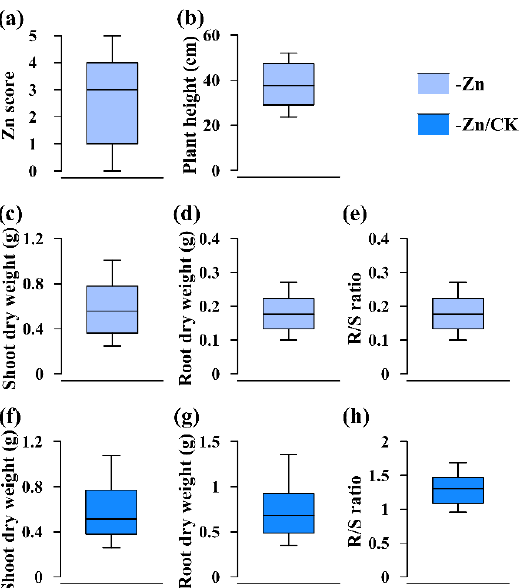
Figure 5. Phenotypic distribution of each trait in the DAN340×K22 RIL population under different conditions (-Zn, -Zn/CK). ( a ) Zn score; ( b ) plant height; ( c , f ) shoot dry weight; ( d , g ) root dry weight; ( e , h ) R/S ratio. The solid line in each box represents the median values. The upper and bottom lines represent the 90th and 10th percentiles, respectively. The top and bottom edge of each box represent the 75th and 25th percentiles,